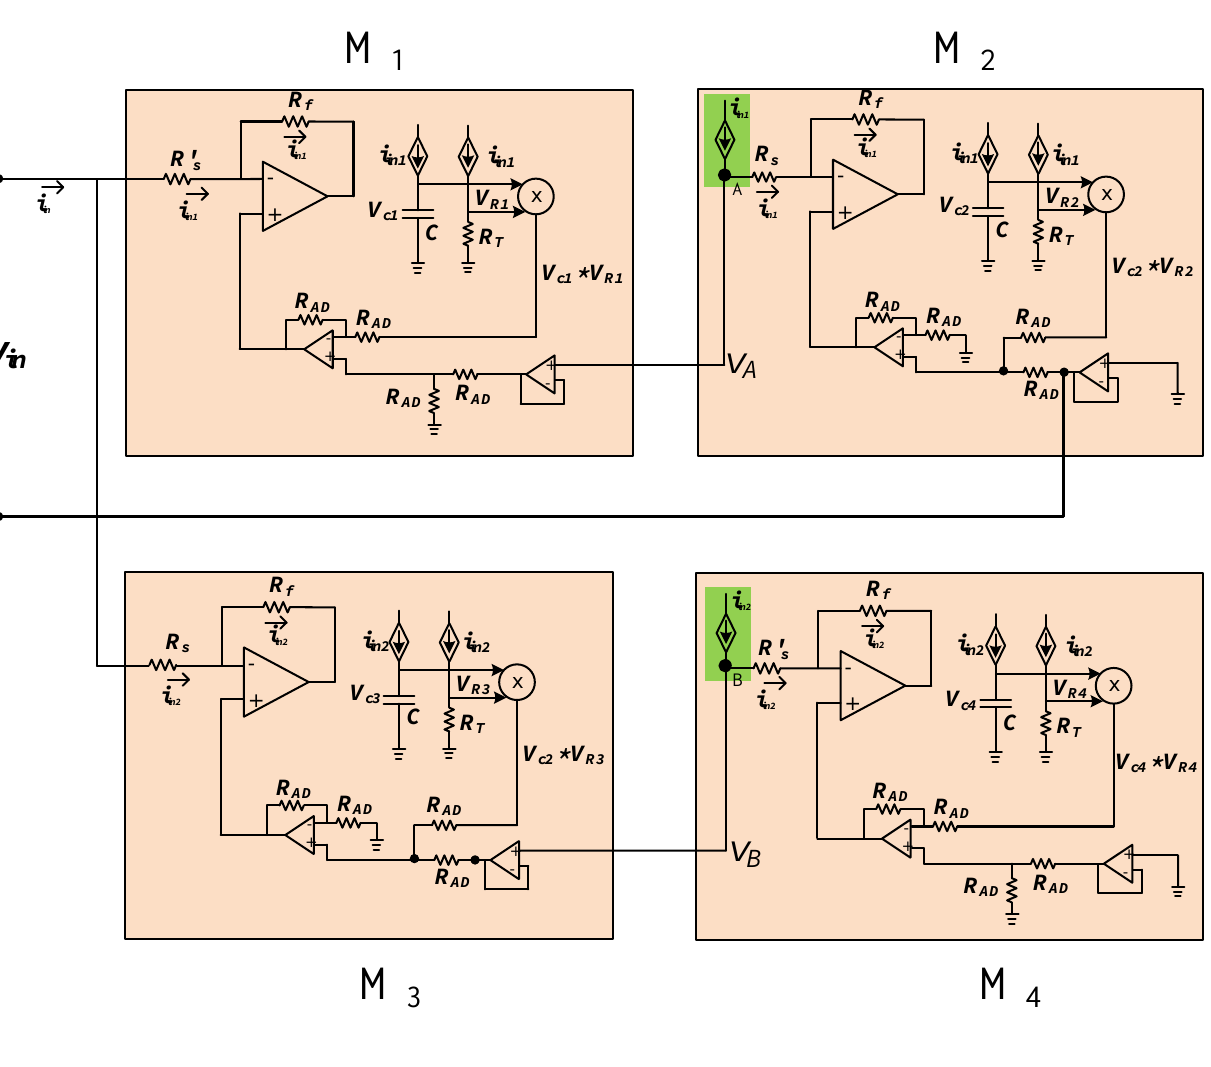
Figure 6. Schematics of memristor emulator-based synaptic circuit corresponding to the synaptic structure of Figure